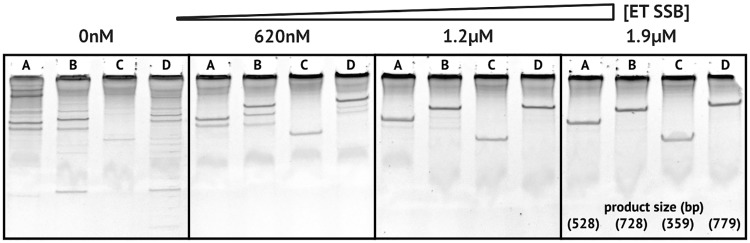
ET SSB reduces off-target activity with TtAgo.Sets of two guides targeting different locations on ΦX174 Virion DNA over increasing concentration of ET SSB. Reactions were carried out at 74 °C for 5 hr and products were analyzed on Novex 20% polyacrylamide TBE gels stained with 3X GelRed in water. Off target cutting is reduced with higher concentrations of ET SSB. (A) 528 nt product using ΦX174 guides 3 and 5; (B) 728 nt product using ΦX174 guides 3 and 6; (C) 359 nt product using ΦX174 guides 1 and 4; (D) 779 nt product using ΦX174 guides 2 and 6.